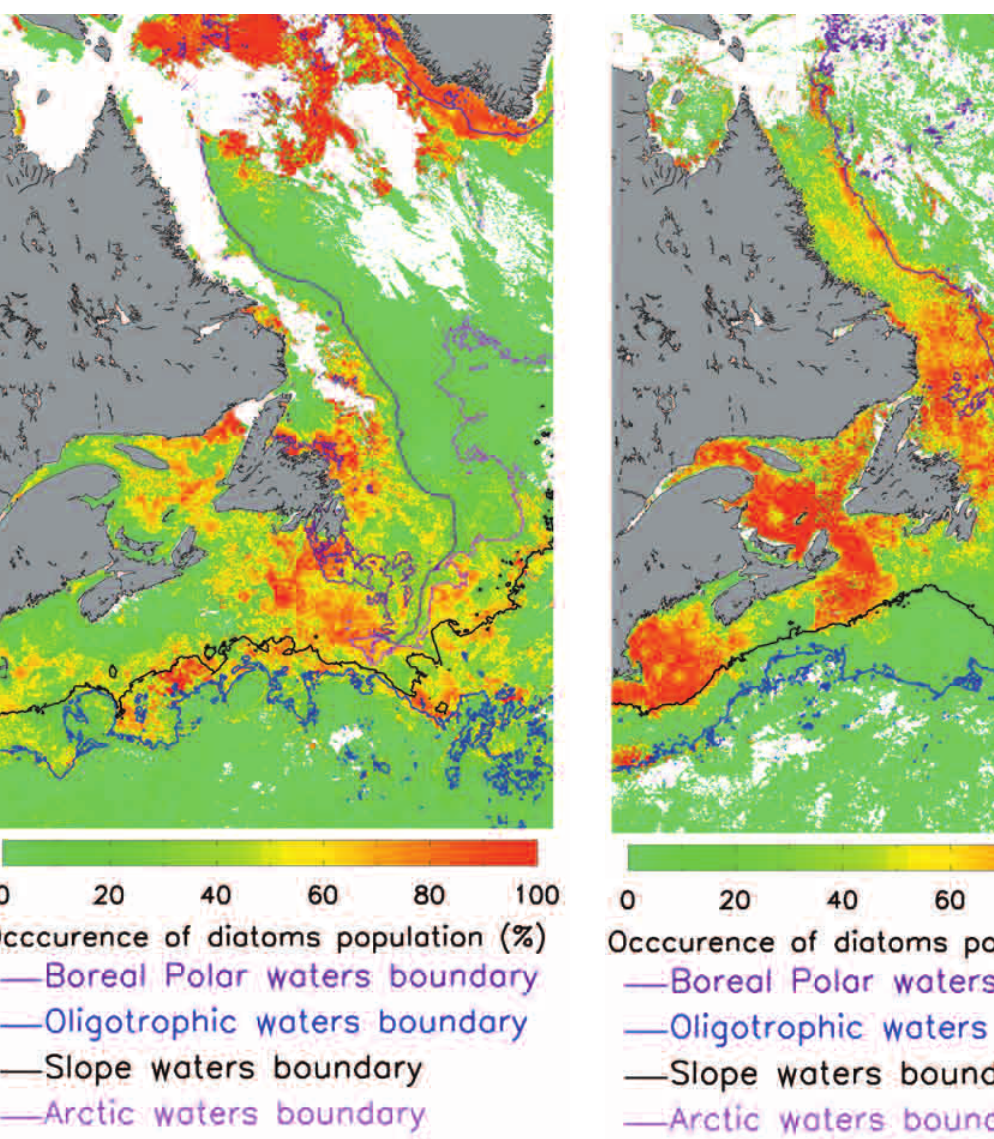
Fig. 10. – Composite image of identification of diatoms during spring. Solid lines correspond to the province boundaries.